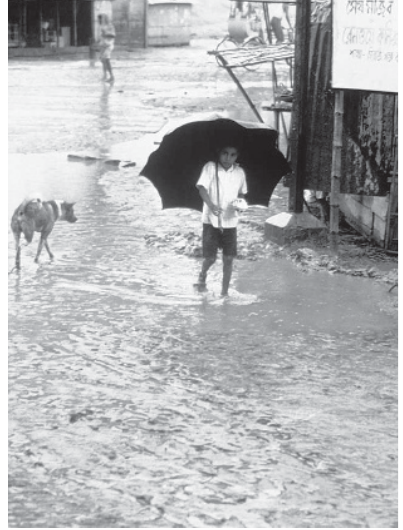
Figure 1. The Role of Rainfall in Driving the Seasonal Nature of Cholera Is Unclear This photograph was taken during a cholera and nutrition survey during fl ooding in Bangladesh in 1974. In Bangladesh, monsoon rains appear to have a seasonal “dilution” effect on transmission, producing a decrease in cholera cases during that season. We don’t know whether extreme rains also produce a lagged increase in cases later on in the cycle. In other parts of the world, cases typically peak during the rainy season. (Photo: Jack